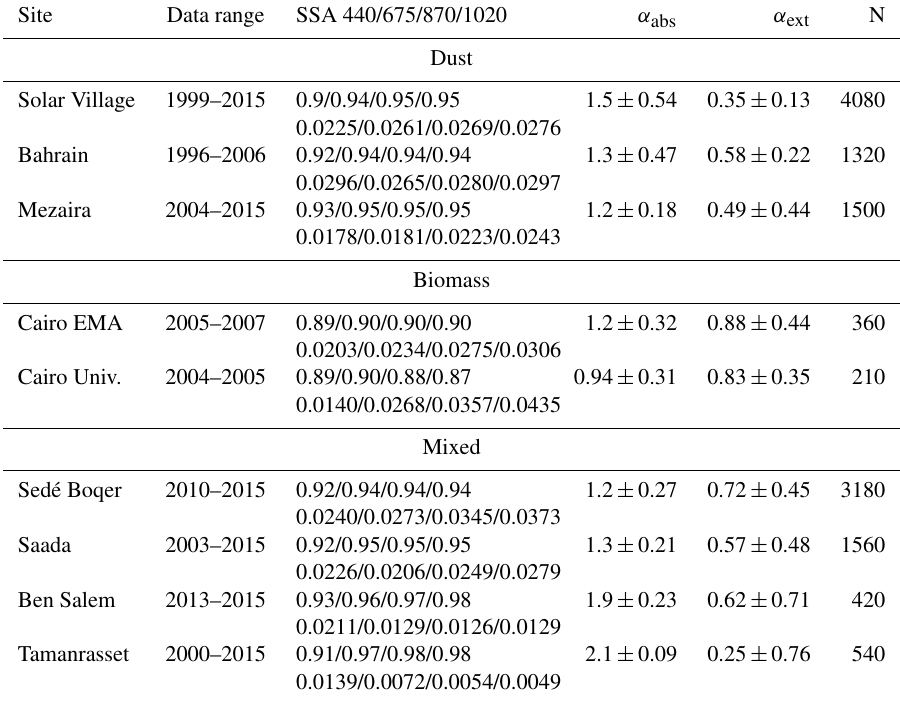
Table 2. Aerosols absorption and physical properties categorized by aerosol types, for sample stations, using AERONET Version 2, Level 2.0 data retrievals. Some locations may experience other aerosol types during different seasons (Cairo, for instance). The spectral single scattering albedo (SSA) is listed first followed by the standard deviations based on monthly values. EMA: Egyptian Meteorology